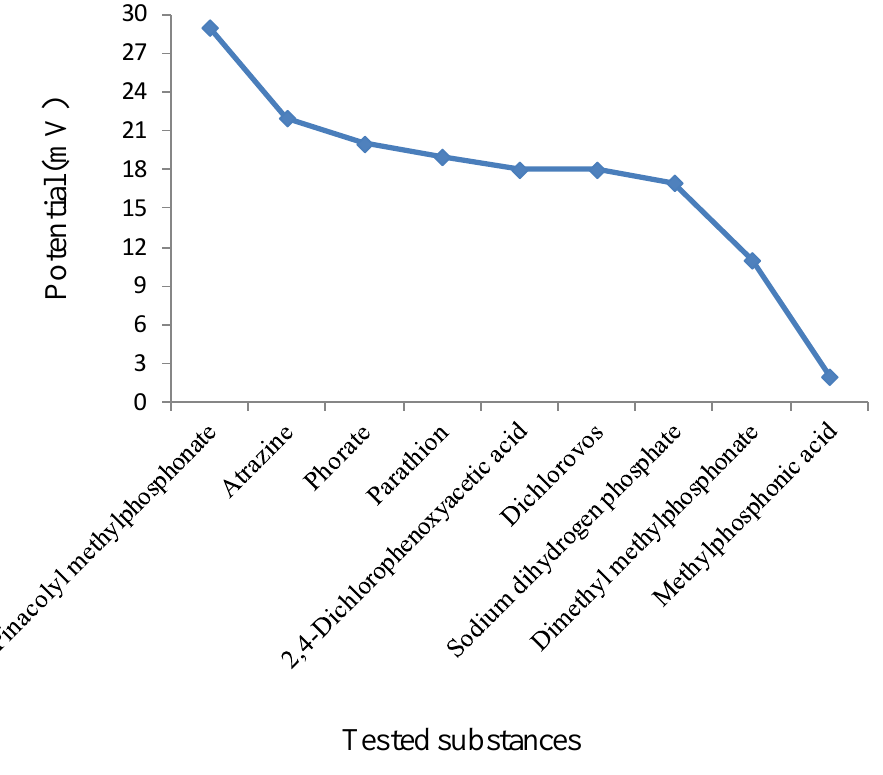
Figure 5. Potentiometric response of the PMP bulk-polymerization based-sensor toward pinacolyl methylphosphonate (PMP) and other common contaminants (Data from